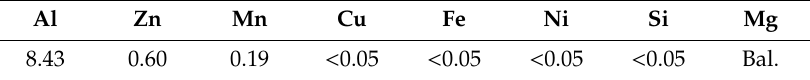
Table 1. Chemical compositions of the experimental AZ80